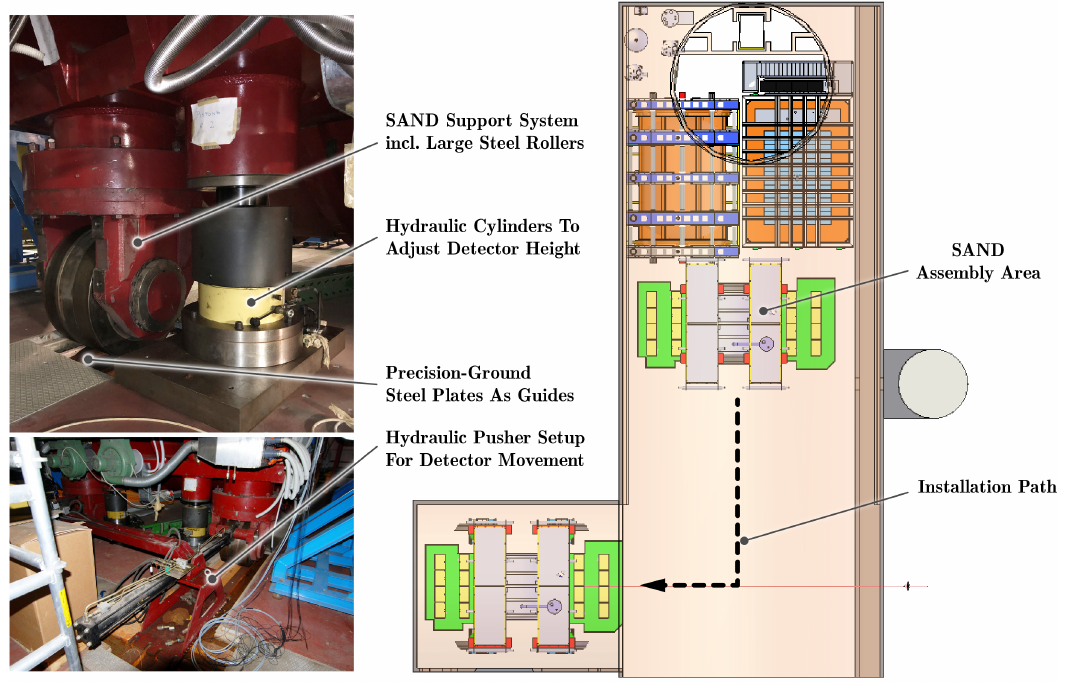
Figure 176. SAND incorporates a versatile support system with large diameter steel rollers for smooth movement and a specialized hydraulic system to adjust the detector height. The steel rollers can be rotated by 90° which permits movement of the beam monitor from its assembly area to the final alcove